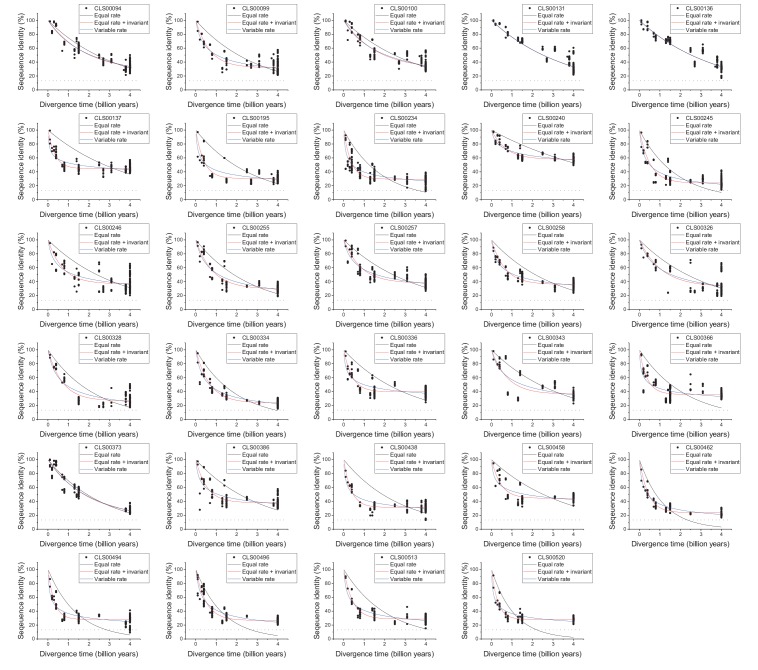
Sequence divergence of non-enzyme orthologs as a function of divergence time.The global pairwise sequence identities between pairs of orthologous proteins that are not part of the EC nomenclature are shown as a function of divergence times between the corresponding species. The colored lines indicate fits to the data using the three models of amino acid substitution (Equations 1-3). The dashed black lines represent the average sequence identity for the global sequence alignment of unrelated protein sequences. Model parameter fits are presented in Supplementary file 2c.10.7554/eLife.39705.010Figure 1—figure supplement 5— source data 1.Sequence identity versus divergence times for 29 non-enzyme families.